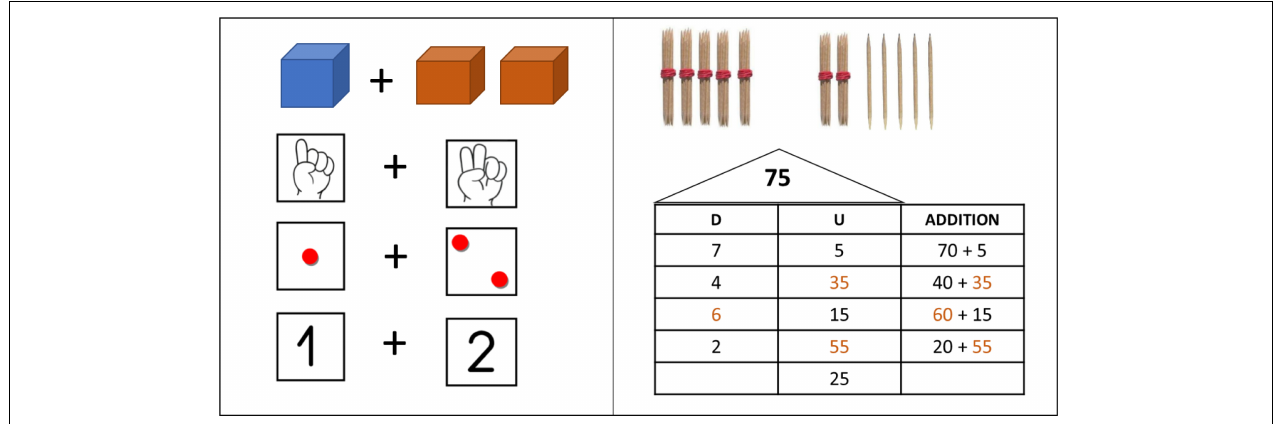
FIGURE 7 | Manipulative resources for teaching mathematics with the Open Algorithm Based on Numbers